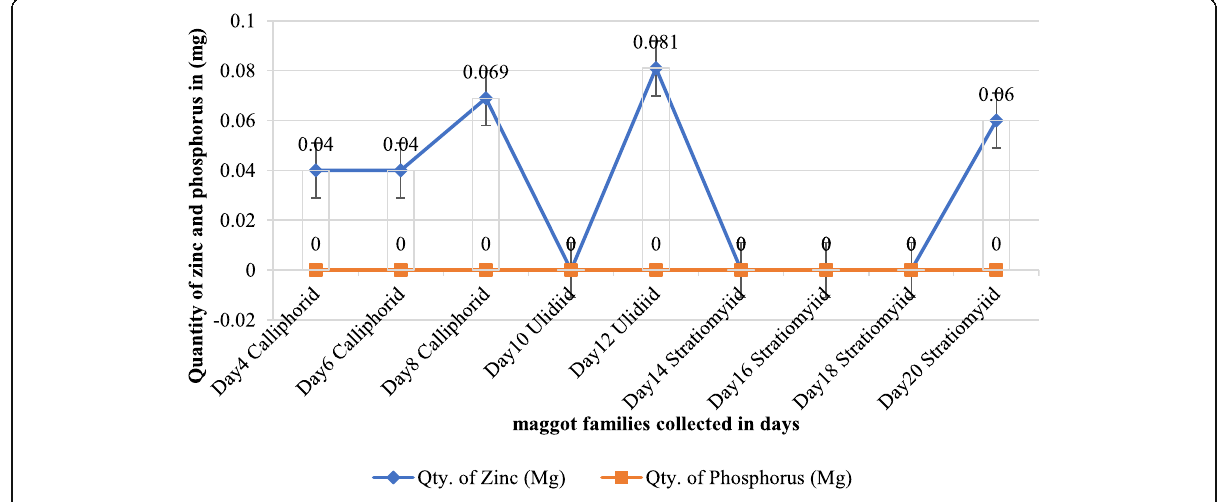
Fig. 6 Quantity of zinc and phosphorus in the maggots during the dry season of Awka,